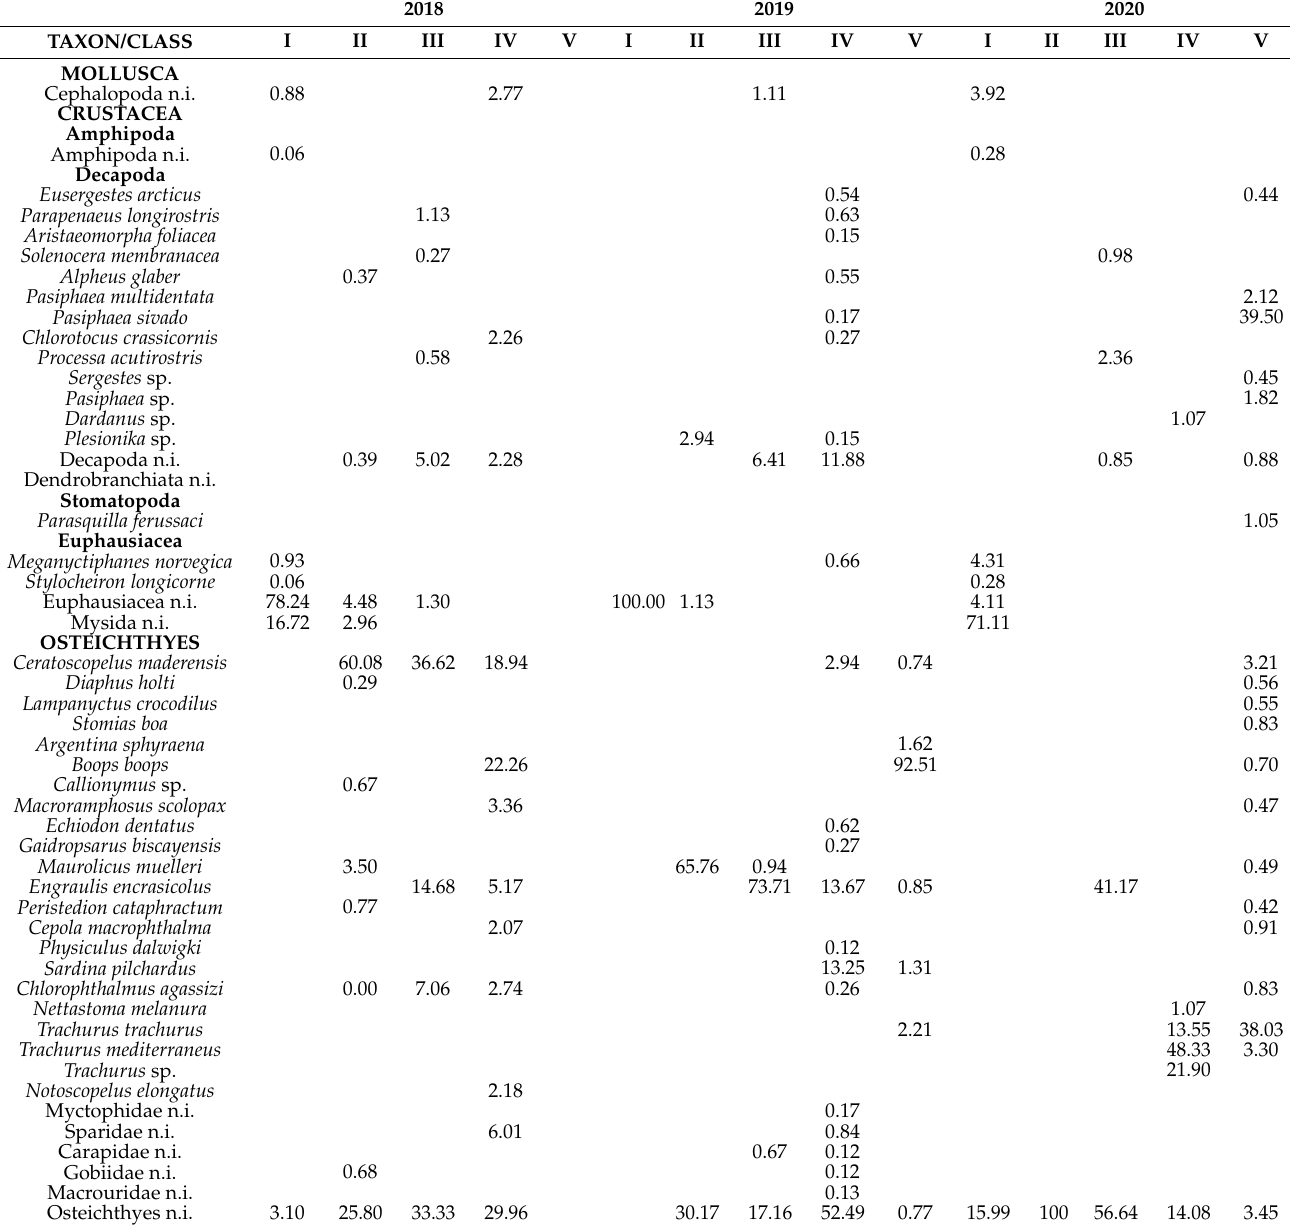
Table 3. Diet composition in the five hake size classes sampled in timeframe 2018/2020. In the column are reported the IRI% values for each prey